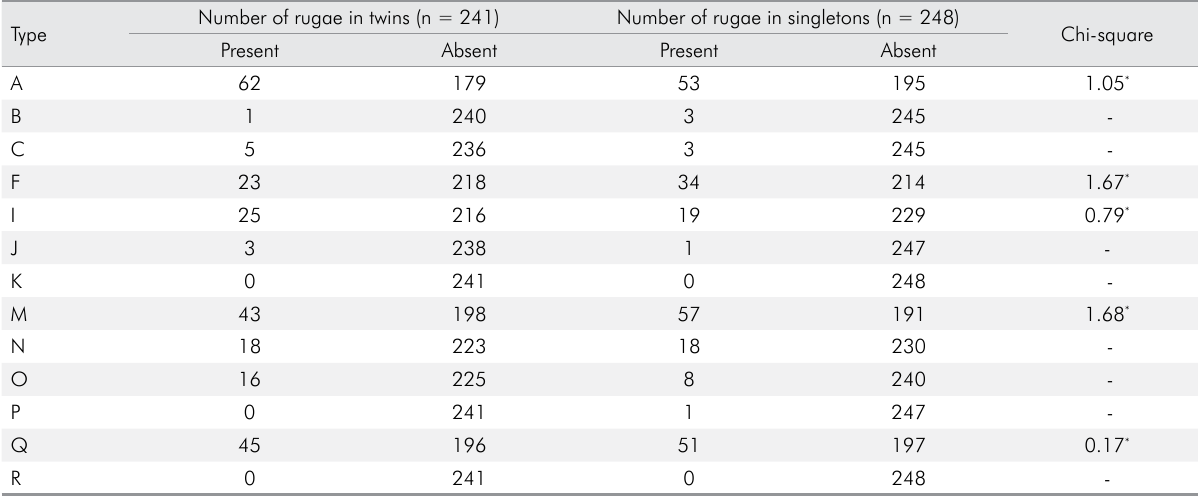
Table 3. Distribution of types of palatal rugae in twins and singletons.